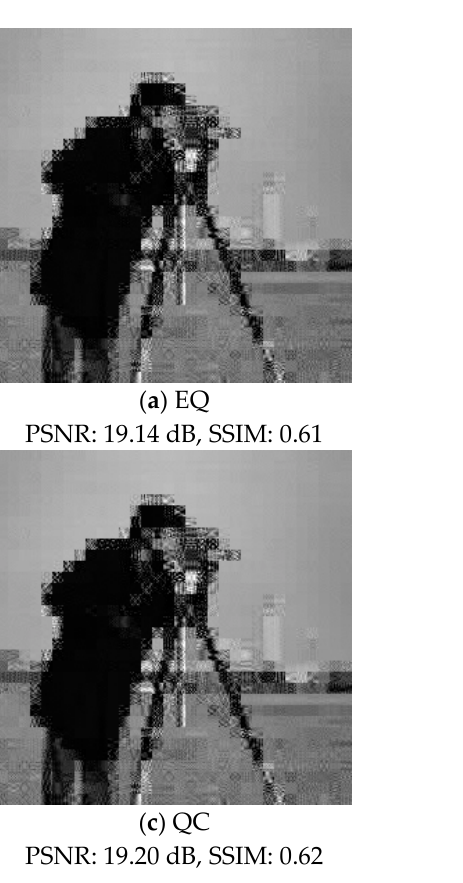
Figure 3. Reconstruction of BCS coefficients: ( a ) equality constraint only (EQ); ( b ) equality constraint and adaptive sampling (EQ + AS); ( c ) quadratic constraint only (QC); and ( d ) quadratic constraint and adaptive sampling (QC + AS).